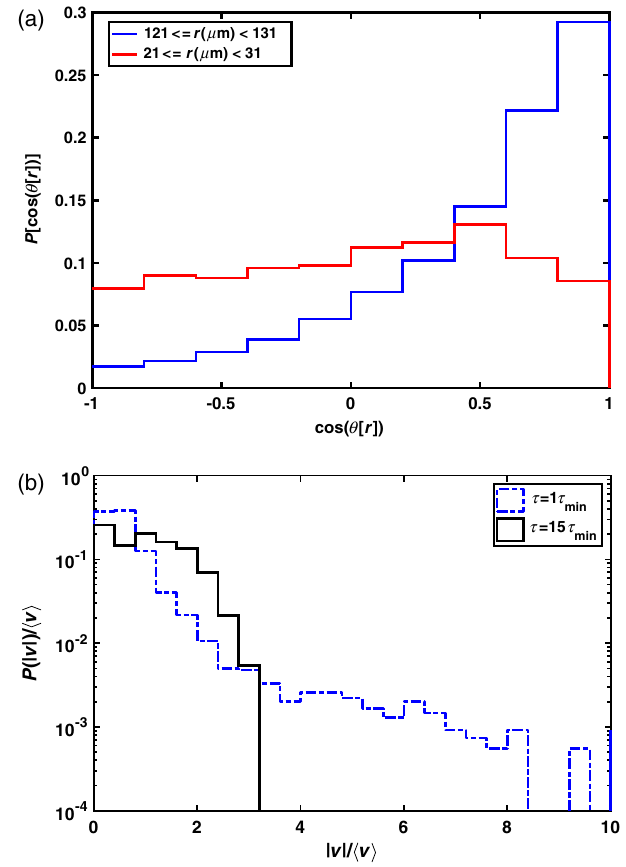
FIG. 15. Heterogeneity in the tumor cell dynamics. (a) Distri- bution of the angle ( θ ) at different distances ( r ) from the tumor center at approximately 3 days ( τ ¼ 0 . 25 τ ). (b) Probability min distribution of the cell speed normalized by mean cell velocity h v i at two different cell cycle times at the long time regime ( t ¼ 5 τ